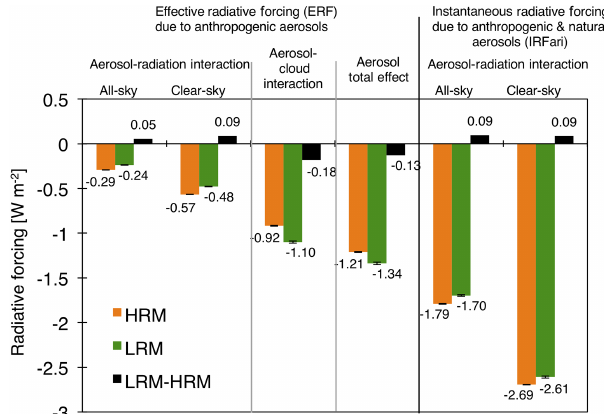
Figure 15. Annual global average ARFs for both ARIs and ACIs, i.e., IRFari, ERFari and ERFaci, against anthropogenic and total aerosols, i.e., anthropogenic and natural sources, under all-sky and clear-sky conditions at the TOA using the HRM (orange), the LRM (green) and the difference (LRM minus HRM in black). All units are in Wm − 2 . The uncertainties are given as the global confidence intervals with a significance threshold of